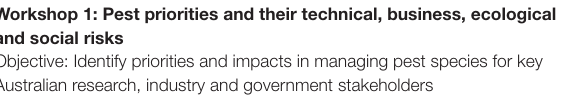
TABLE 1 | Synopsis of workshop participants, methods and